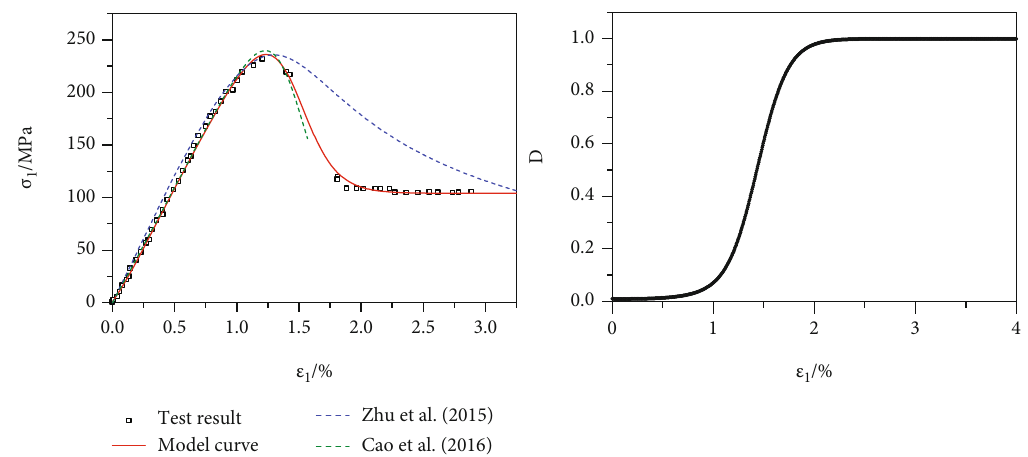
Figure 16: Axial stress-strain curve and damage curve under con fi ning pressure of 30MPa.